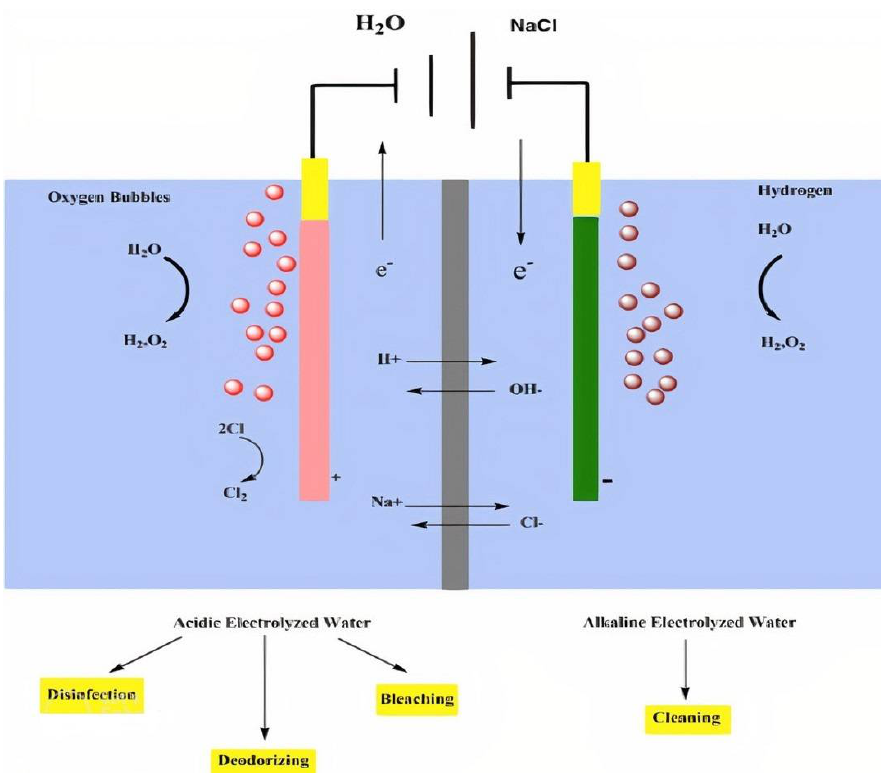
Figure 1. Schematic diagram of electrolyzed water manufacturing .